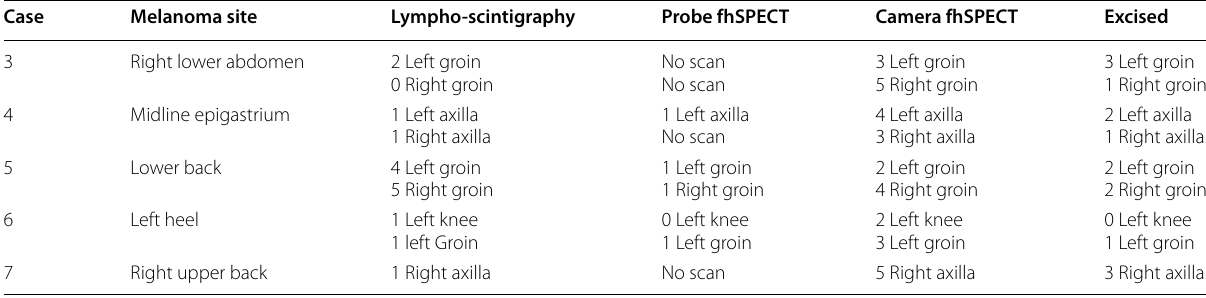
Table 1 Number and location of SLNs imaged by lymphoscintigraphy, preoperative probe fhSPECT, and preoperative camera fhSPECT, and number and location of SLNs subsequently excised during